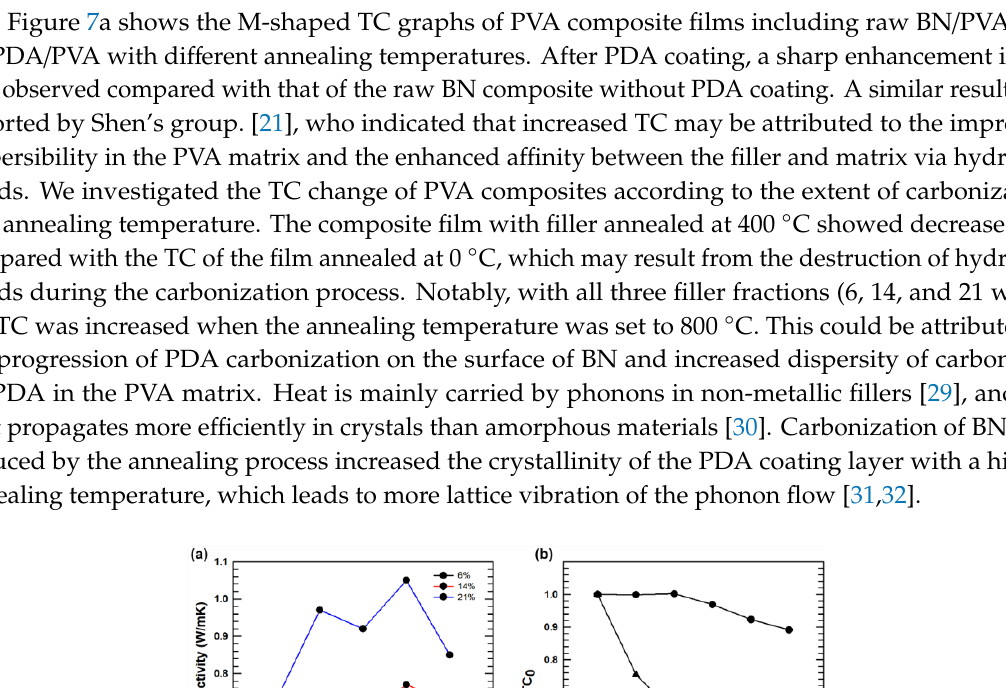
Figure6. Cross-sectionalFE-SEMimagesofPVAcompositefilmsfilledwith( a )BNPDA,( b )BNPDA-400, Figure 6. Cross-sectional FE-SEM images of PVA composite films filled with ( a ) BNPDA, ( b ) BNPDA- ( c ) BNPDA-800, and ( d ) BNPDA-1000. 400, ( c ) BNPDA-800, and ( d ) BNPDA-1000.